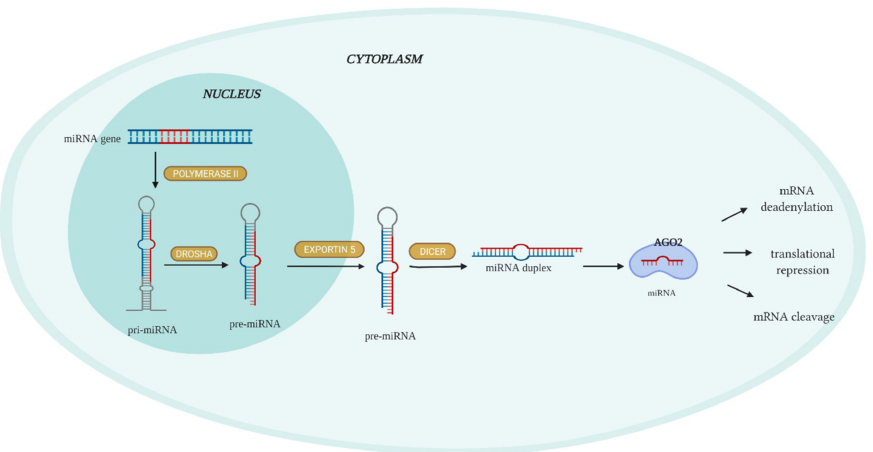
Figure 1. MicroRNA (miRNA) biosynthesis and functions. MiRNA gene is transcribed by polymerase II to primary RNA (pri-miRNA). The ribonuclease Drosha is involved in the process of changing